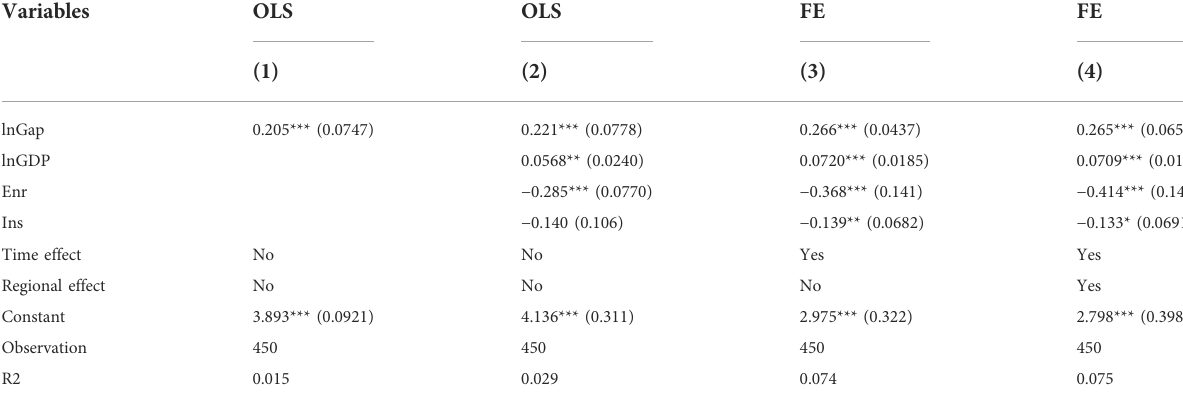
TABLE 2 Local effect test.